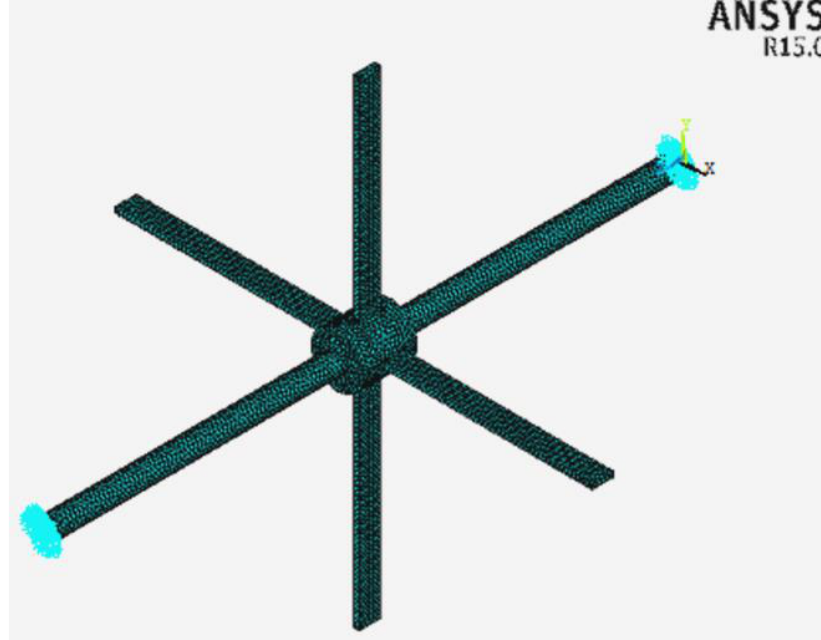
Figure 2. Boundary conditions of the rotating blades.